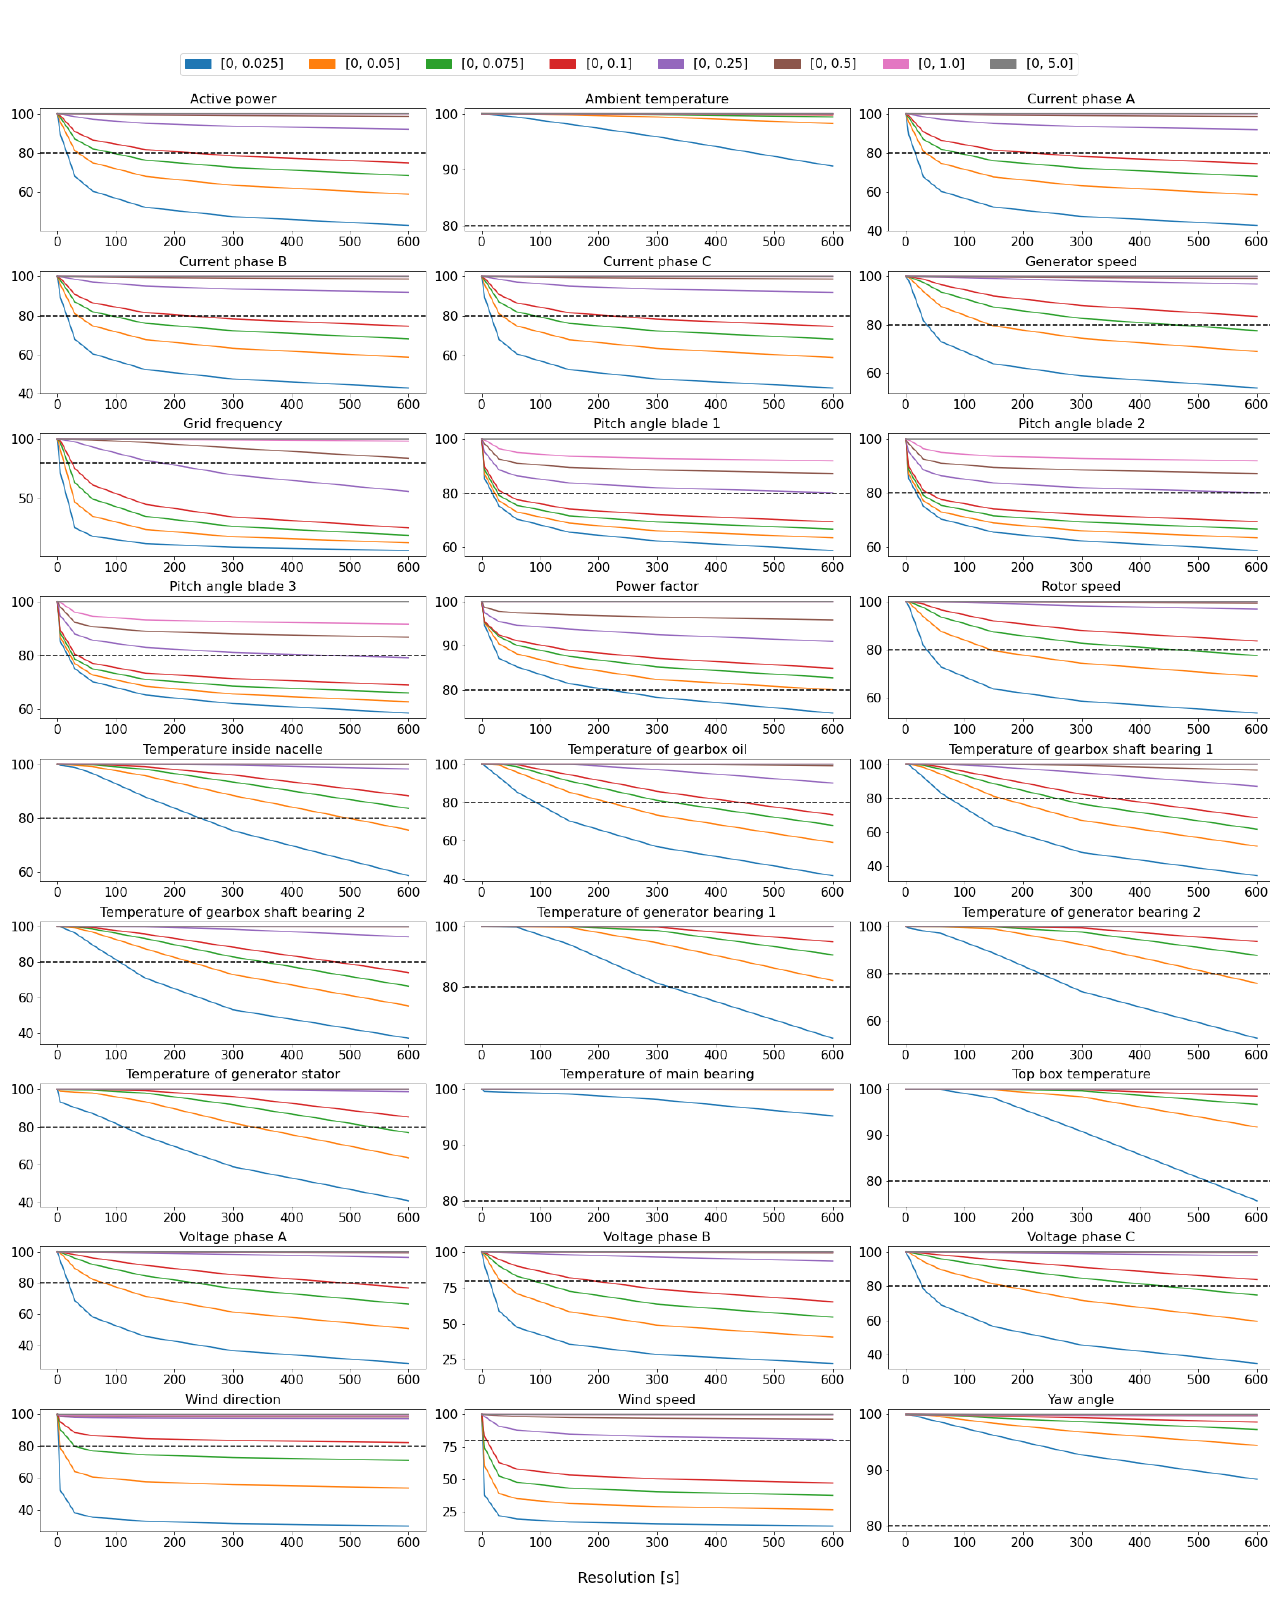
Figure 12. Relation between temporal resolution of the aggregated signal and percentage P [ ∆ t ] of data below a given error thresholds. Multiple error limits Λ max are represented with different colors, see legend. The scale of the y-axis is not fixed to magnify changes in signals. A black horizontal line is drawn for a value of 80% of the data to improve readability and comparison of the different plots. Labelling of the axes was omitted for a less overloaded presentation: The x-axes denote the time resolution ∆ t , the y-axes the data percentage P of data inside [ 0, Λ max ]